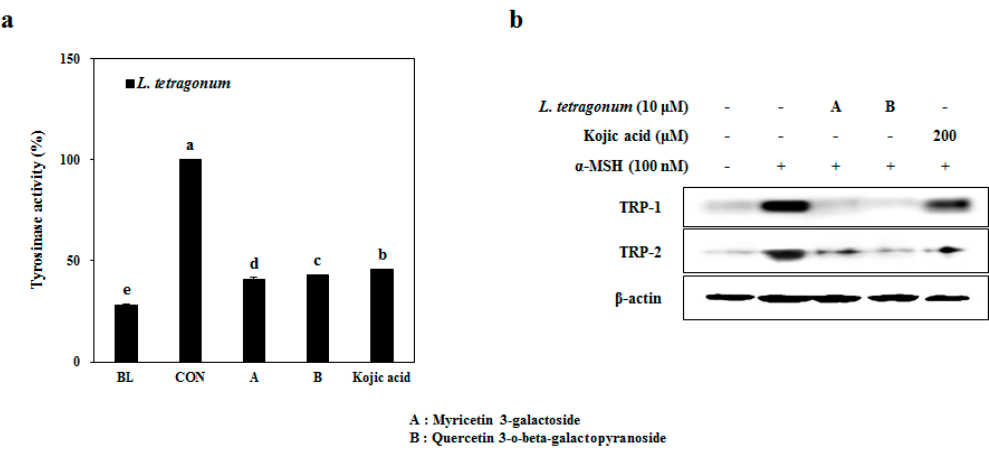
Figure 6. Inhibition of cellular tyrosinase activity ( a ) and protein levels of TRP-1 and TRP-2 ( b ) in B16- F10 cells by isolated compounds. a–e Means with the different letters are significantly different ( p < 0.05) by Duncan’s multiple range test among same samples compared to control group.